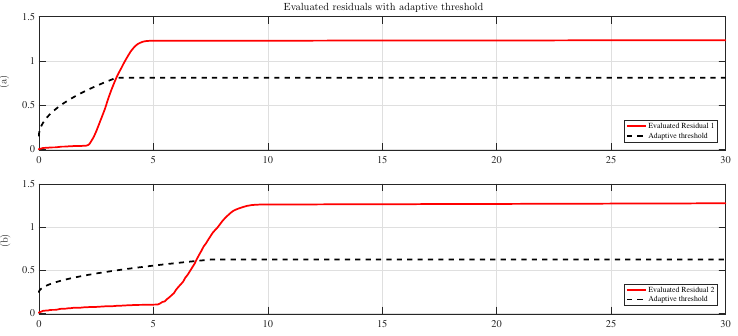
Figure 12. ( a ) Evaluated residual with adaptive threshold for Mode 1. ( b ) Evaluated residual with adaptive threshold for Mode